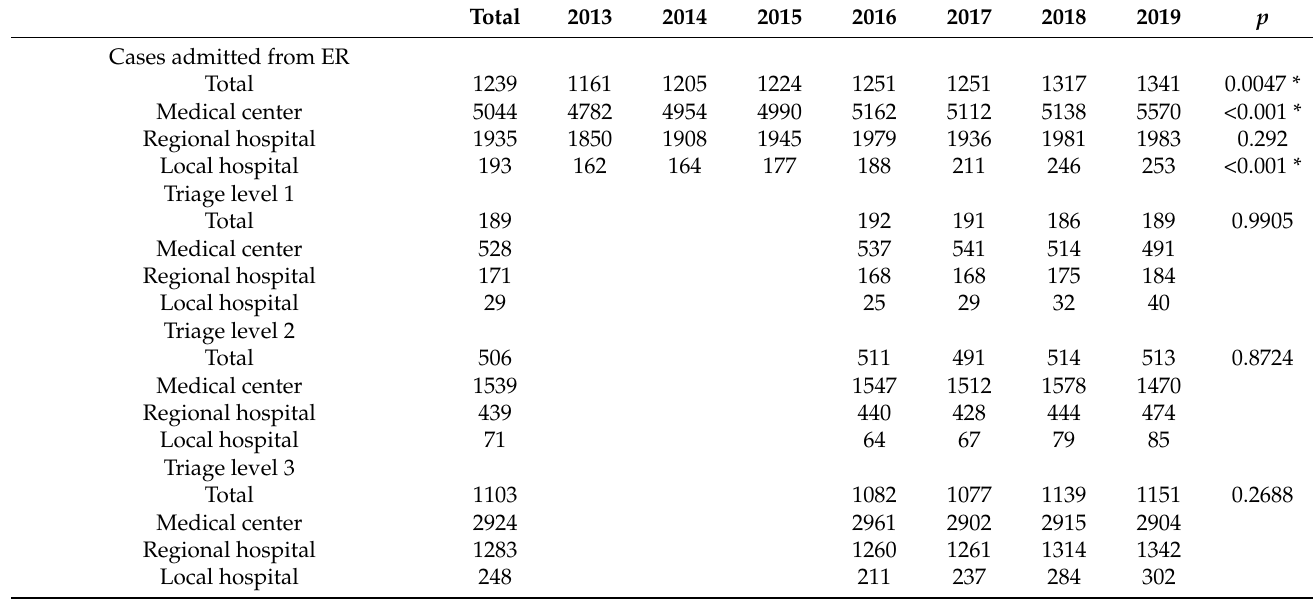
Table 2. The average hospitalizations of patients in different hospital levels and triage levels.